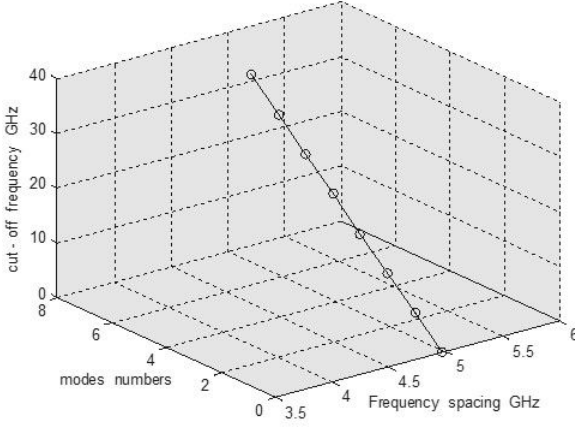
Figure 5: The optical carrier source with the frequency spacing